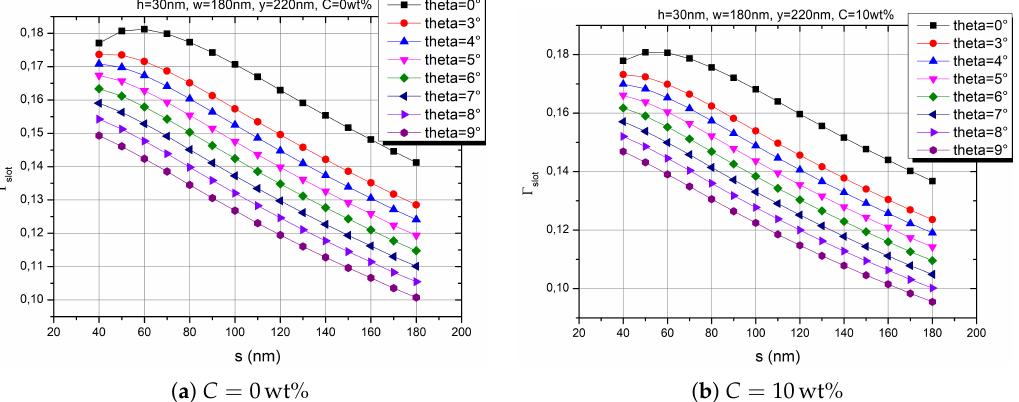
Figure A2. Field confinement factor Γ slot for both concentrations as a function of s and with θ as